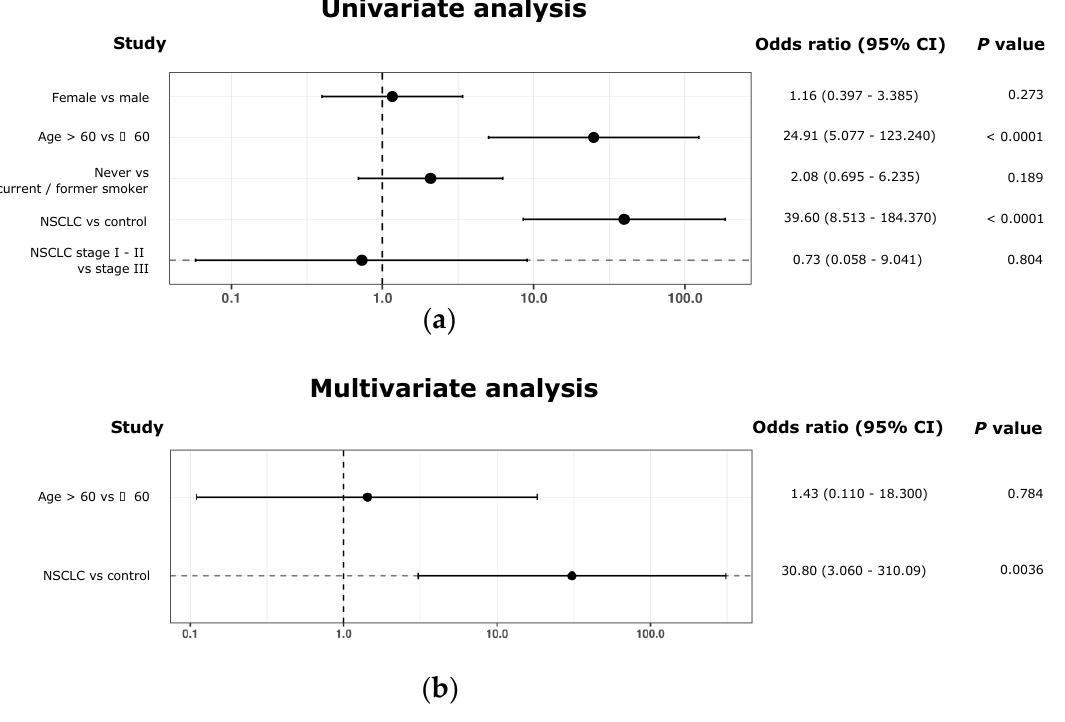
Figure 9. Association between clinical characteristics and ML-generated 10-circRNA signature. ( a ) Univariate analysis exploring associations between presented 10-circRNA signature and patient characteristics. Forest plot represents the odds ratios with a 95% Wald confidence limit. ( b ) Multi- variate analysis exploring associations between presented 10-circRNA signature with age and cancer status. Forest plot represents the odds ratios with a 95% Wald confidence limit.